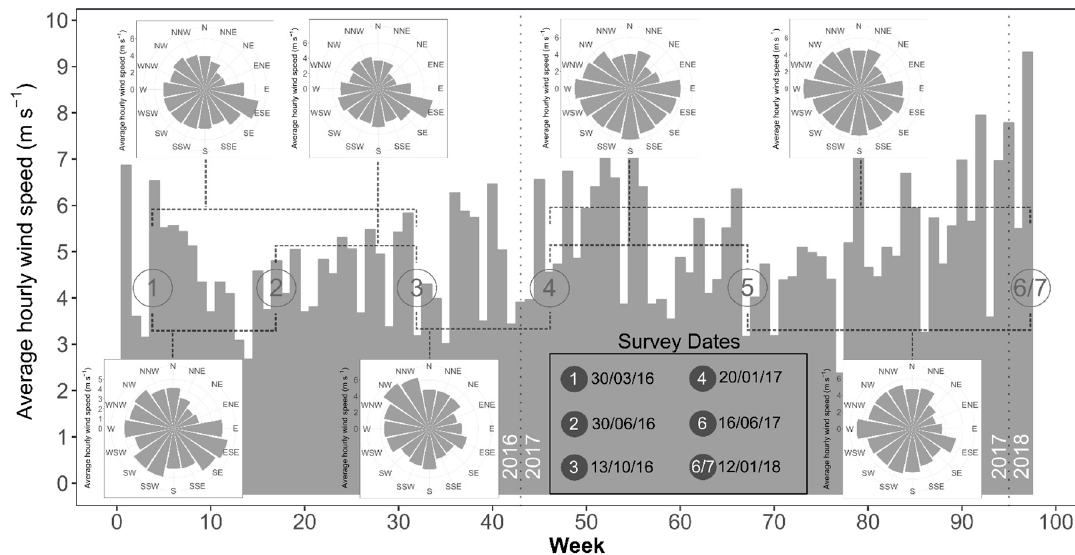
Figure 2. Wind profile characterising the study system using weather data from Camborne weather station (located approximately 5 km east of St Gothian Sands nature reserve). Histogram displays average hourly wind speed (grouped by week) throughout the study period, and wind roses indicate average hourly wind speed and direction during the periods between pairs of the six KAP and drone surveys used in analysis (indicated by number labels). Weather data obtained from Met Office DataPoint Service (https://www.metoffice.gov.uk/datapoint; contains public sector information licensed under the Open Government